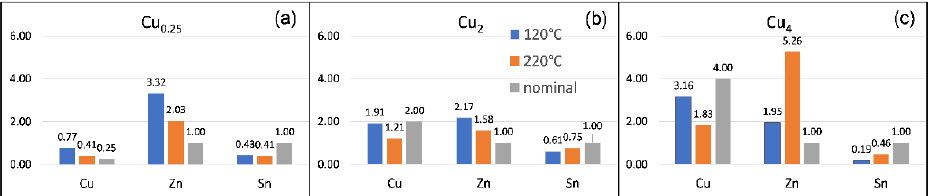
Figure 1. Actual (XPS-derived) and nominal (loaded during synthesis) ratios of metallic elements normalized with respect to the sulfur content (S 4 ) of the CZTS NC films with different Cu content for the initial (120 ◦ C) and annealed (220 ◦ C) samples: ( a ) Cu 0.25 ; ( b ) Cu 2 ; ( c ) Cu 4 . The compositions in atomic % can be found in the Supplementary Materials (Table S1).